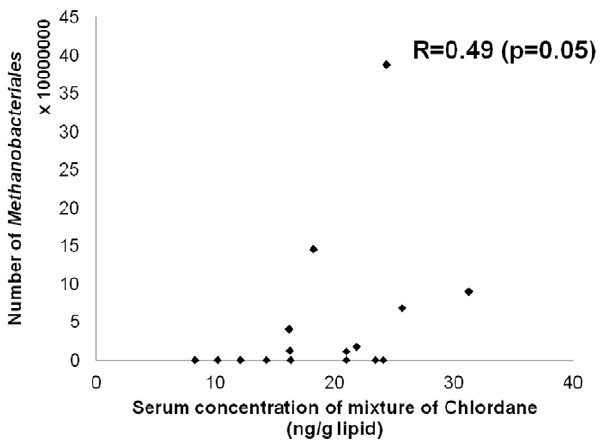
Figure 2. Scatter plot beween serum concentrations of mixture of organochlorine pesticides belonging to Chlordane (oxy- chlordane, trans- Nonachlor, cis- Nonachlor, Heptachlor epox- ide) and number of Methanobacteriales (n=16). When one subjects with the highest number of Methanobacteriales (38.7 6 10 7 ) was excluded, the correlation coeffficent was 0.45